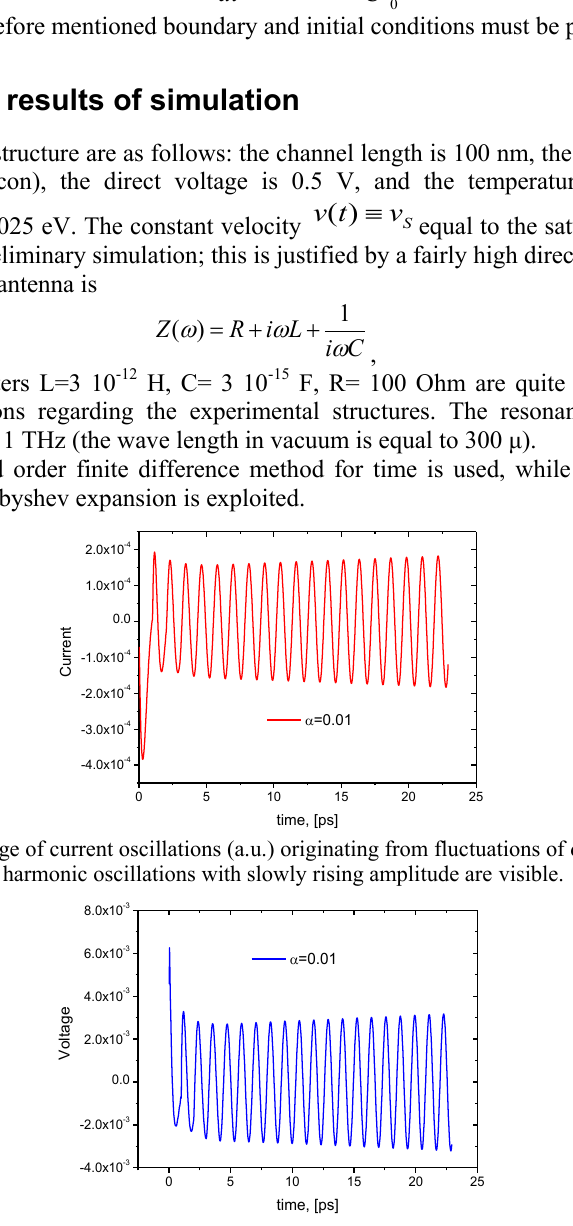
Fig. 4. The initial stage of voltage oscillations (a.u.) originating from fluctuations of density in the channel. Quite harmonic oscillations with slowly rising amplitude are